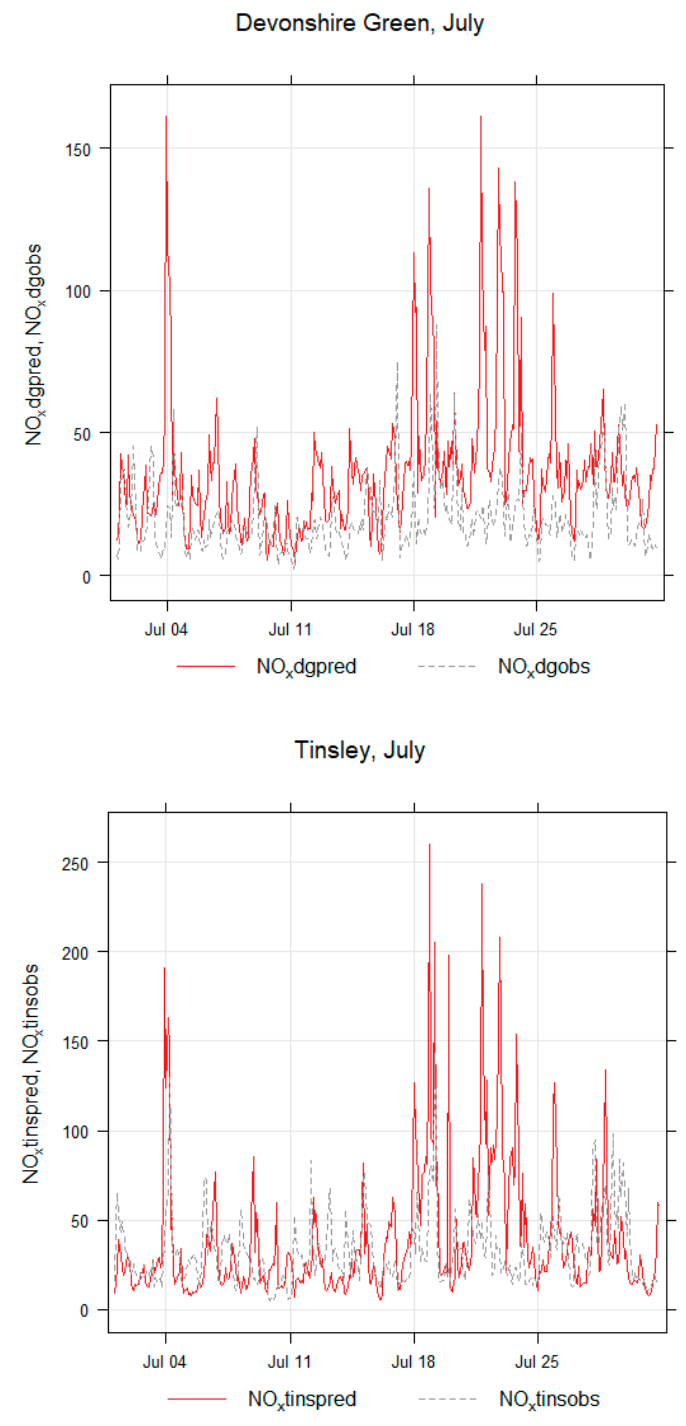
Figure 10. Comparison of modelled and monitored NOx at both Devonshire Green (dg) and She ffi eld Tinsley (tins) for the month of July